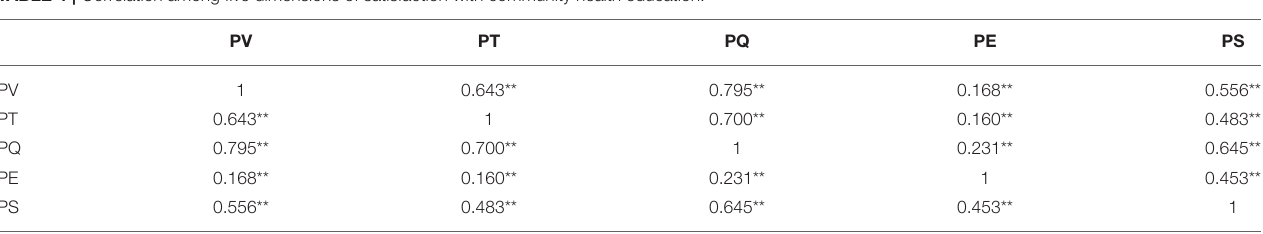
TABLE 4 | Correlation among five dimensions of satisfaction with community health